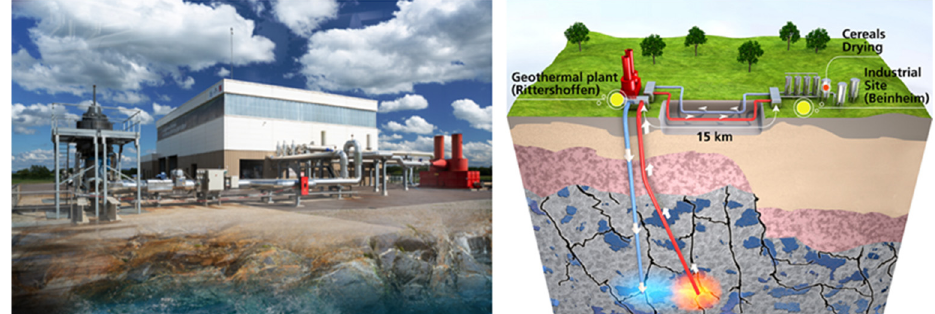
Figure 1. View of the Rittershoffen geothermal plant and schematic representation of the plant suppling heat to the industrial user (credits: ES group).